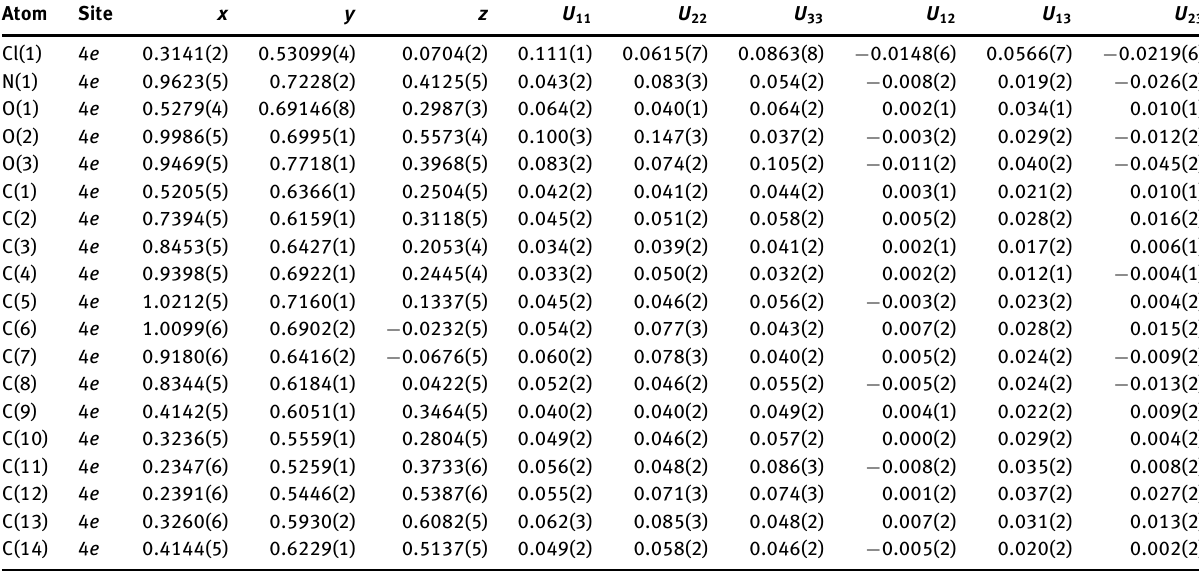
Table 3: Fractional atomic coordinates and displacement parameters (Å 2